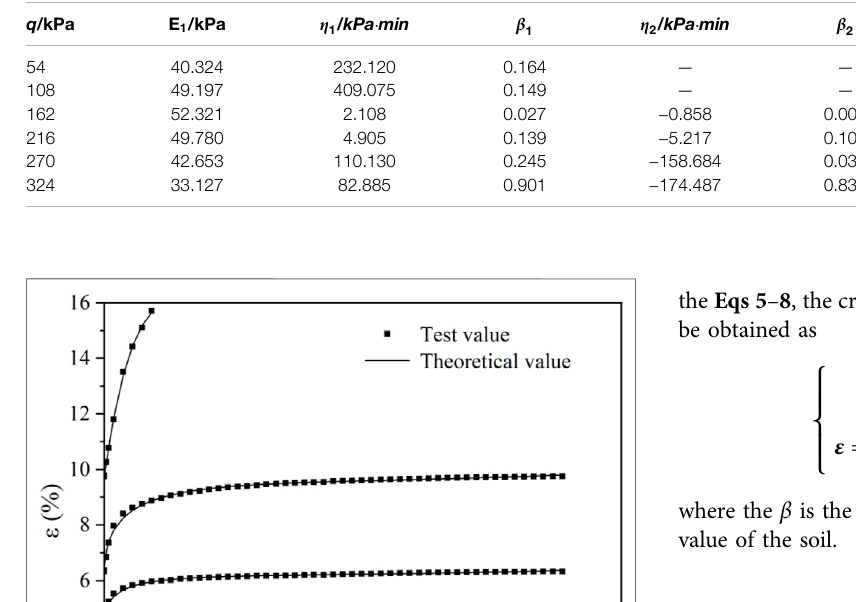
TABLE 2 | Parameters of fractional-order damage creep model.